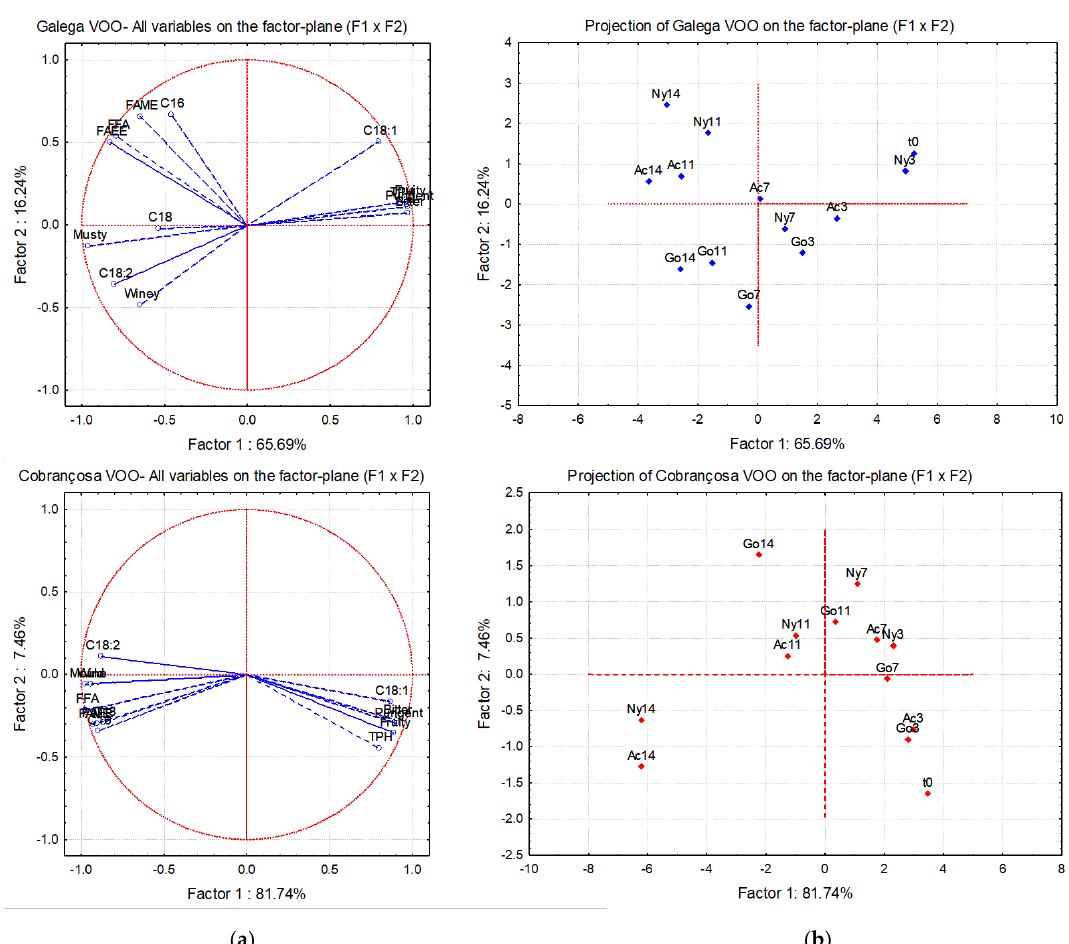
Figure 7. Projections of the loadings of the original variables ( a ) and Galega or Cobrançosa VOO samples ( b ) obtained from fruits inoculated with C. acutatum (Ac), C. nymphaeae (Ny), and C. godetiae (Go), at times 0, 3, 7, 11, and 14 d.p.i., on the planes defined by first and second factors (principal components). Variables: FFA- free fatty acids; FAEE- fatty acid ethyl esters; FAME- fatty acid methyl esters; TPH- total phenolic content; sensory scores: fruity, bitter, pungent, musty, and winey; fatty acids- C16:0, C18:0, C18:1, and C18:2).